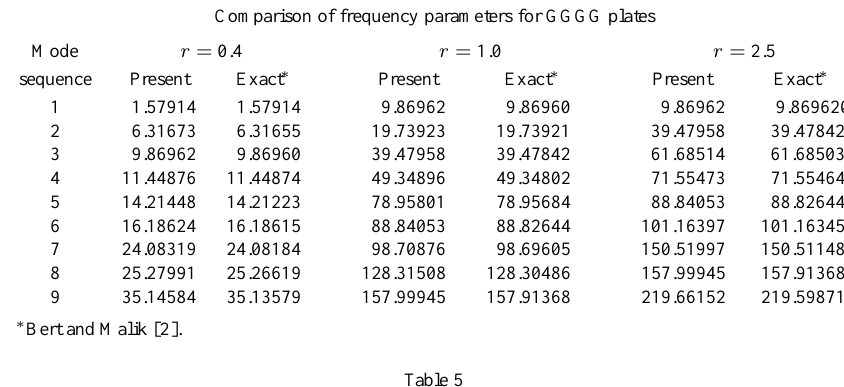
Table 4 Comparison of frequency parameters for GGGG plates